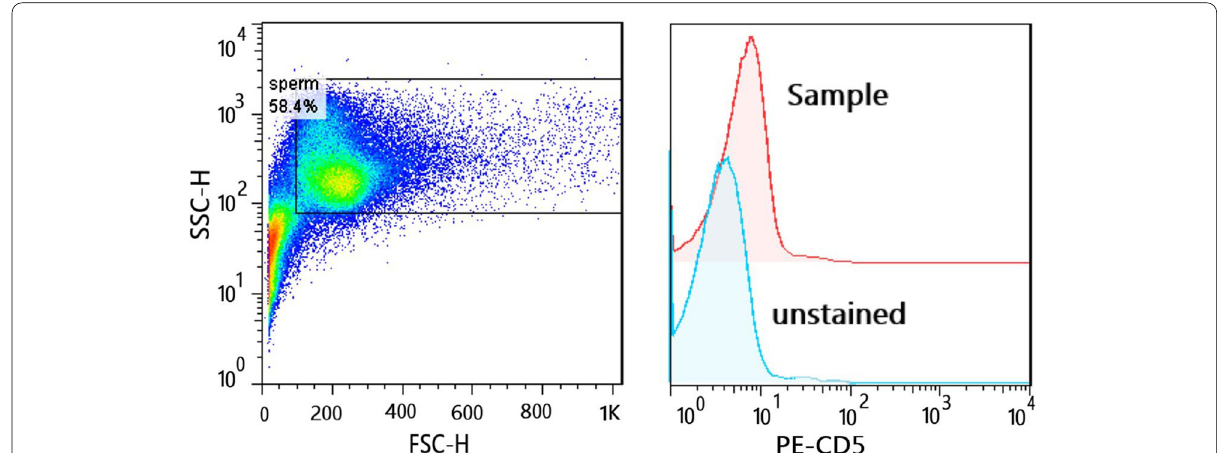
Fig. 1 Representative flow cytometry gating plots and histogram of unstained control and sample. Unstained control was used to differentiate the negative and positive